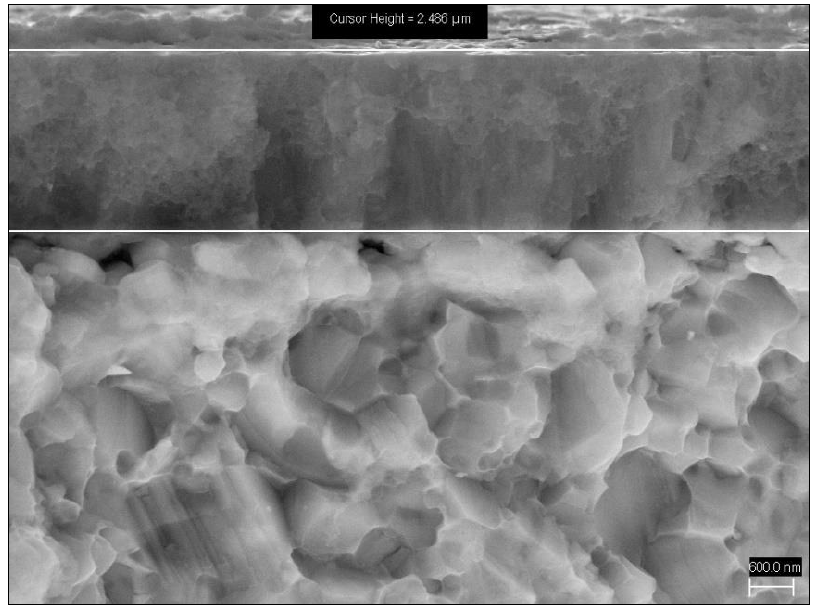
Figure 1. Fracture surface of the (Ti,Al)N coating deposited on cermet substrate.